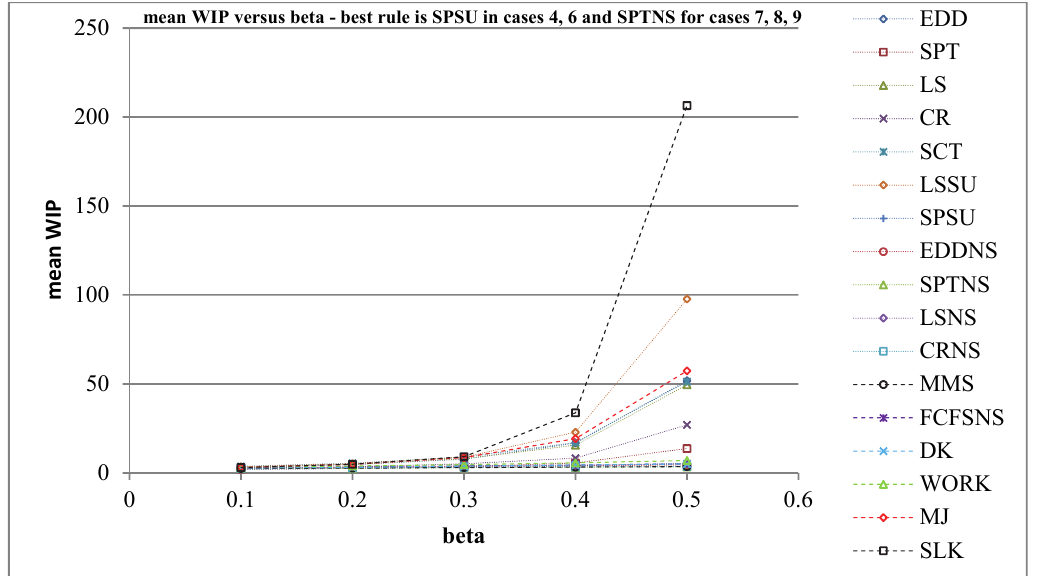
Fig. 5. Mean WIP for simulation cases 4, 6, 7, 8,